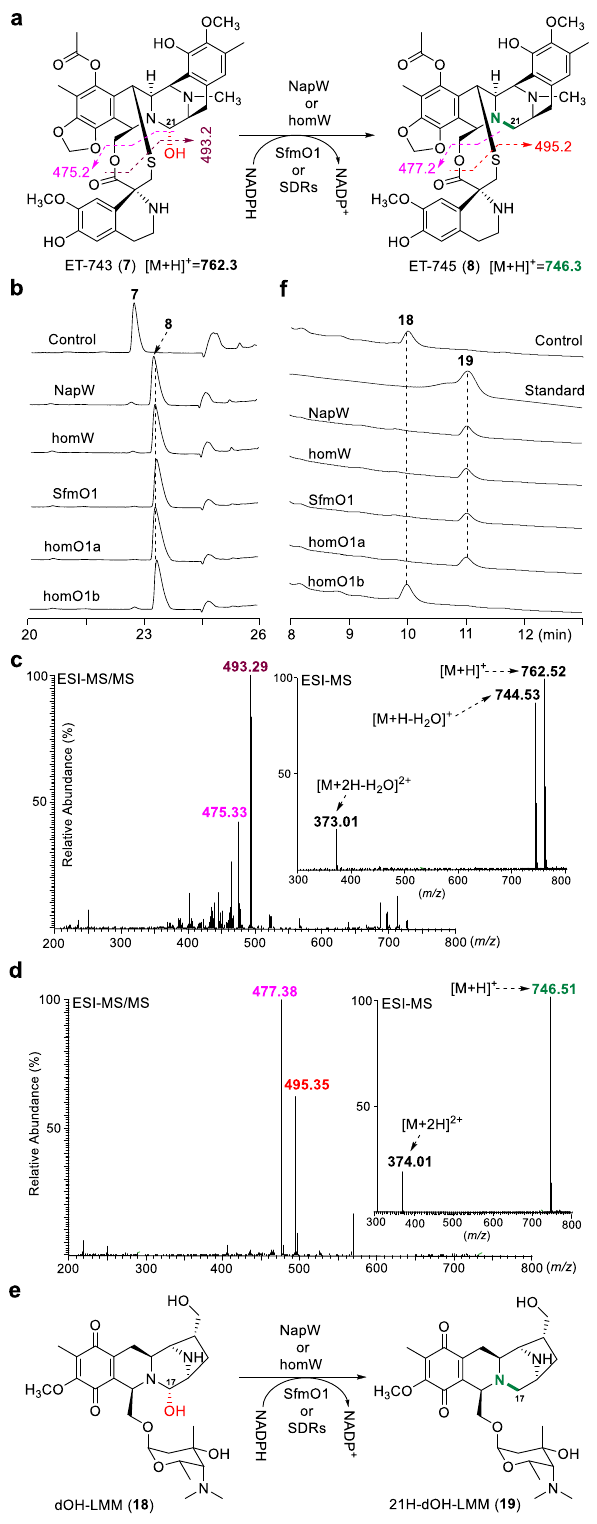
Fig. 6 Biochemical assay of SDRs-catalyzed reduction using ET-743 and dOH-LMM as substrates. SDRs-catalyzed reactions using 7 ( a ) or 18 ( e ) as substrate. HPLC analysis of enzymatic reactions with 7 ( b ) or 18 ( f ) as substrate. ESI-MS and ESI-MS/MS analysis of substrate 7 ( c ) and product 8 ( d